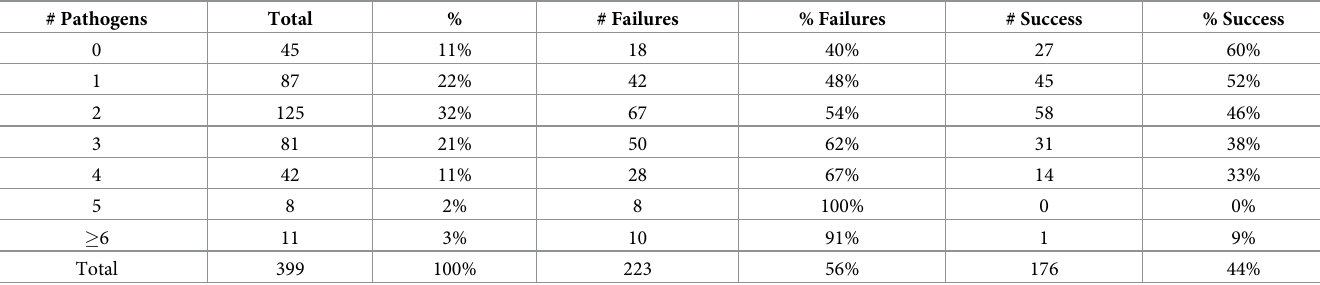
Table 9. BRD treatment outcomes by number of BRD pathogens isolated at 1 st